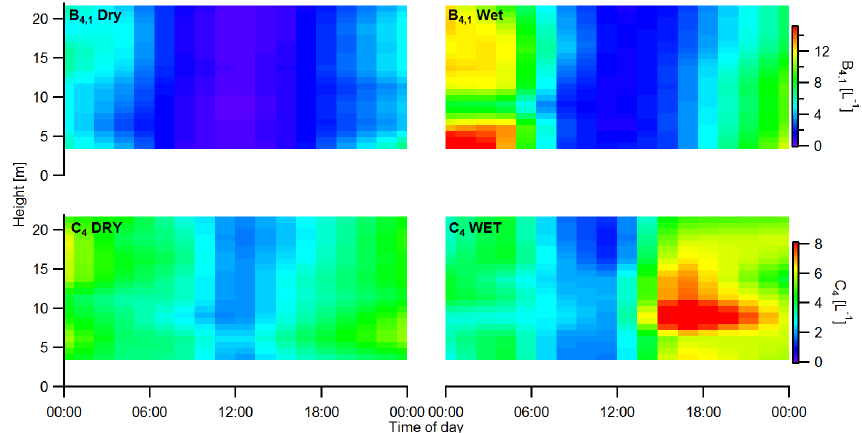
Fig. 9. Diurnal concentration profile of cluster B 4 , 1 (top row) C 4 (bottom row) for dry (left column) and wet (right column) periods. where the effect of a minimum threshold RH can clearly be seen; there is a sharp increase in number concentration at 795 20:00 when RH sharply increases above ∼ 60 % . B 3 parti- cle number concentration decreases again dramatically when RH decreases below approximately 40 % (08:30). Relative humidity has been demonstrated to be related the emission of fungal spores by several studies with Hirst (1953) first 800 noting the direct relationship between Basidiomycota fun- gal spore release and RH. Later, Pringle et al. (2005); Elbert et al. (2007) demonstrated that Basidiomycota actively eject spores and that the mechanism was controlled directly by re- sponse to ambient relative humidity. Gabey et al. (2010) also 805